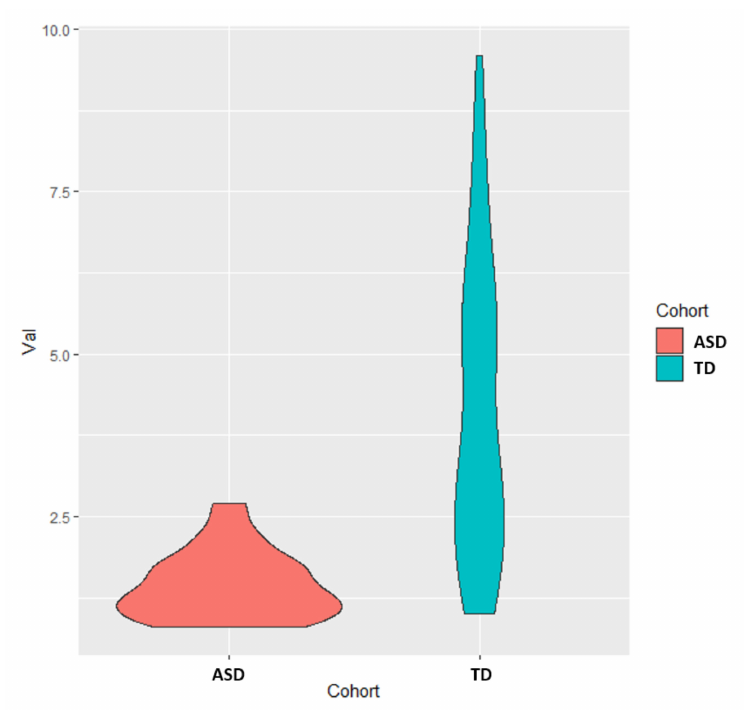
Figure A1. Univariate distribution for free sulfate in plasma, which was the metabolite that had the highest AUROC